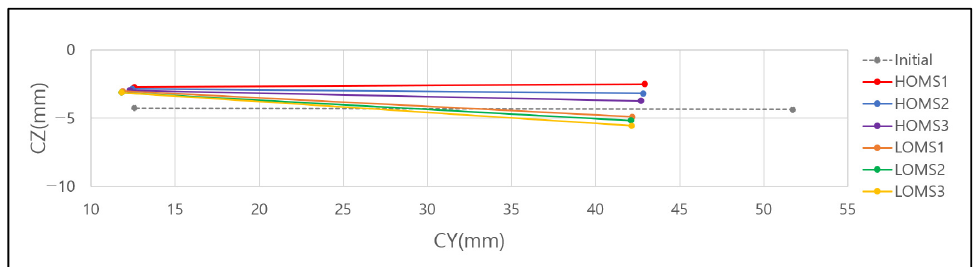
Figure 8. Changes of occlusal plane. Table 7. Angle and difference in angle value of occlusal plane after initial and space closing. Angle of Initial Occlusal Angle of Occlusal Plane Angle Differences Plane (Deg.) after Space Closing (Deg.)